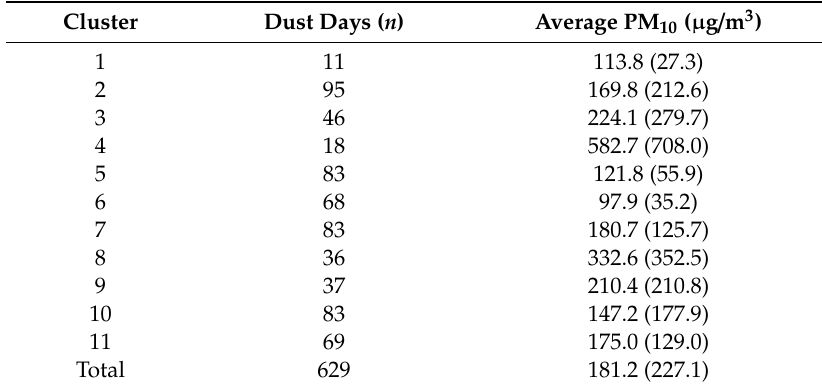
Table 2. Average PM 10 concentration ( µ g / m 3 ) within each cluster (200 m). Standard deviations are in parentheses.